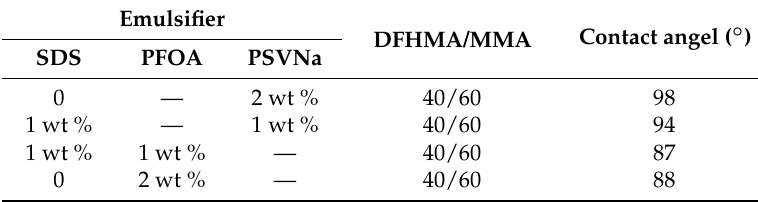
Table 3. Contact angle of latex films with different